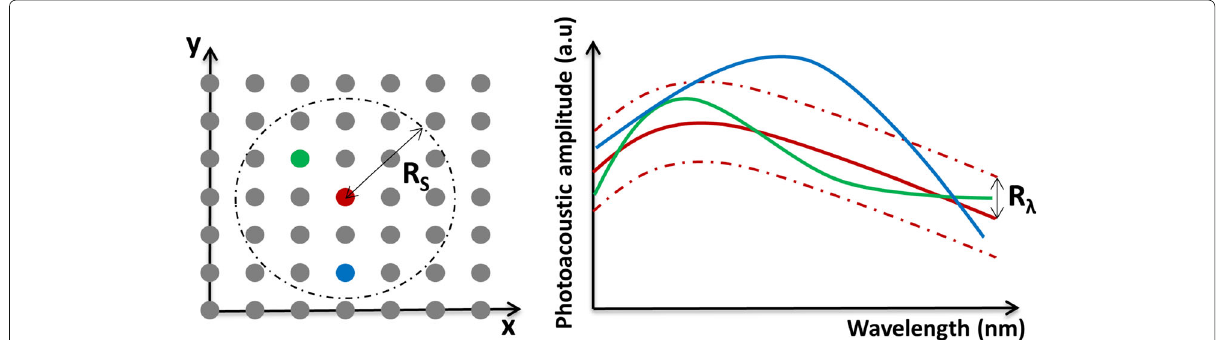
Fig. 1 The spatio-spectral mean-shift principle. Pixel spatial features at the first iteration with the R S parameter (left) and spectral profiles of three pixels with the R λ parameter (right). The red pixel is the reference pixel. Although the green and blue pixels are both in the spatial area of the reference pixel, only the green pixel is used to update the features of the reference. Indeed, the spectral profile of the blue pixel is not close enough to the spectral profile of the reference sample (by at least one wavelength; the blue and red pixels are separated by a distance greater than R λ